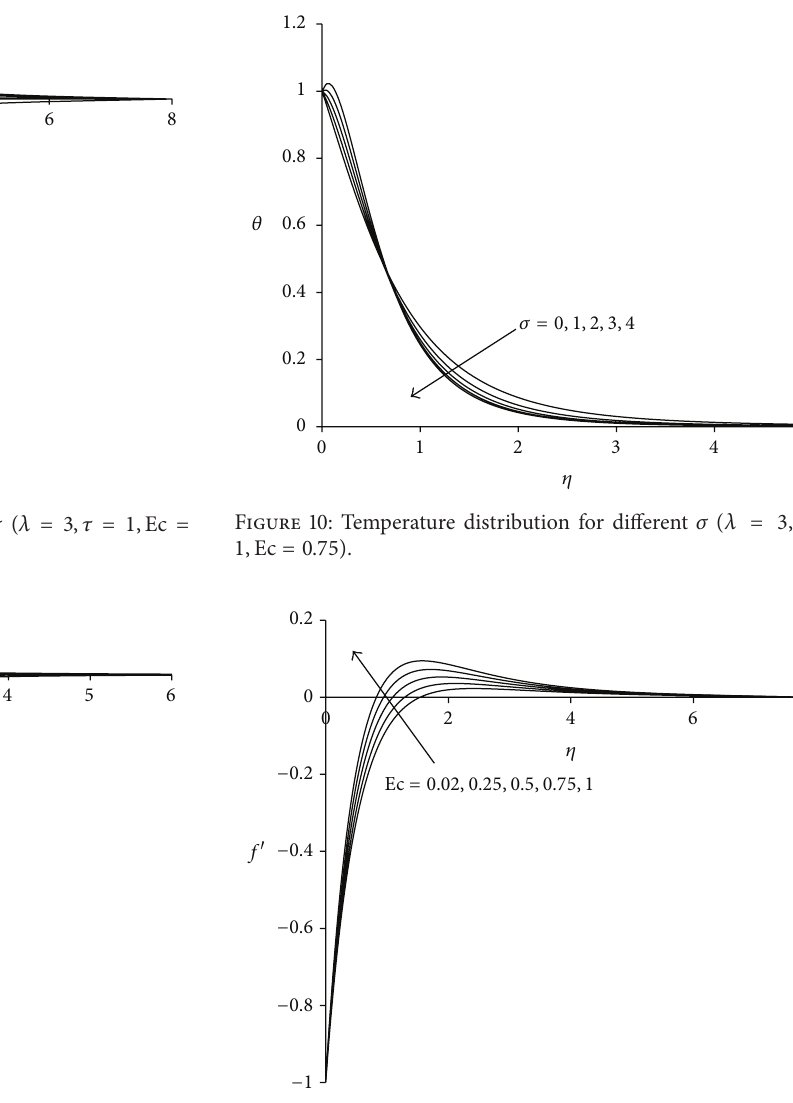
Figure 9: Microrotation distribution for different 𝜎 (𝜆 = 3,𝜏 = 1, Ec = 0.75) .